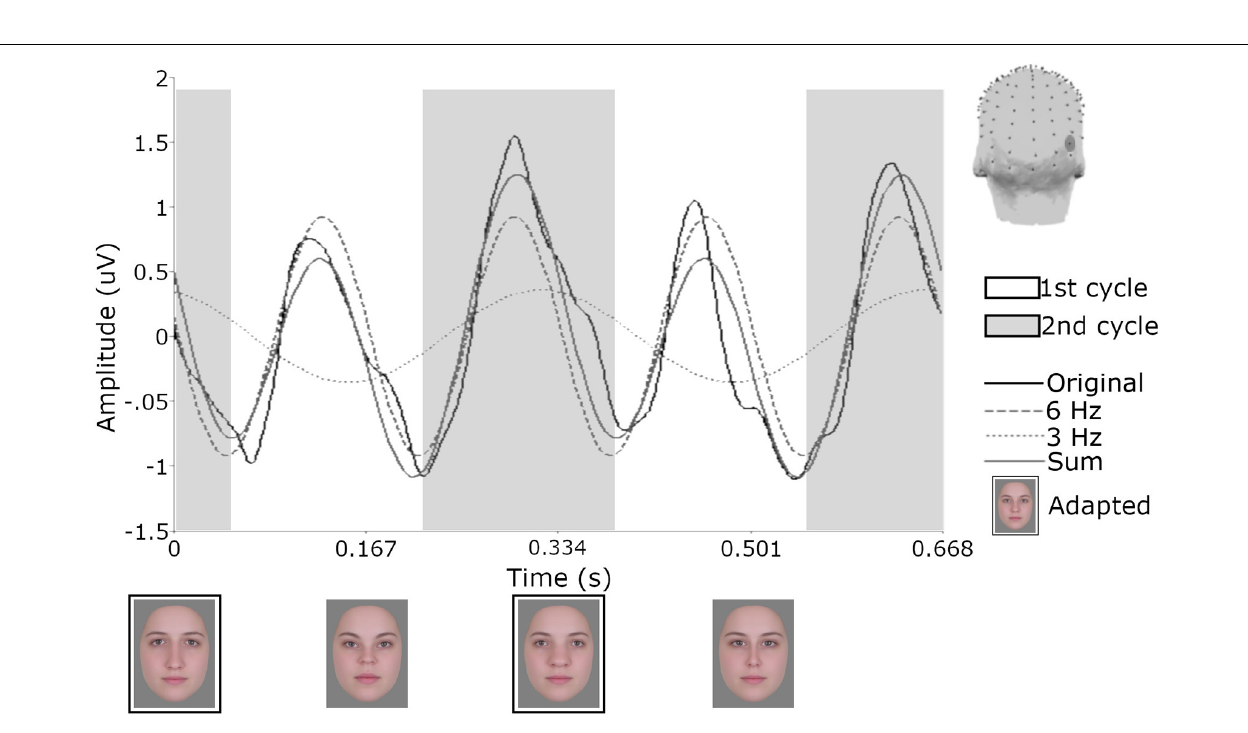
FIGURE 5 | Responses from one participant for electrode PO10 following adaptation to the orthogonal single condition. Across the 20 s test sequence data were segmented in 29 epochs of 670 ms and then averaged. Shaded areas demonstrate how the signal would be defined as first and second cycles of the 6 Hz waveform and the influence of the 3 Hz signal. Face images with black borders are constituents of the single adapting image. The head model shows the location of electrode